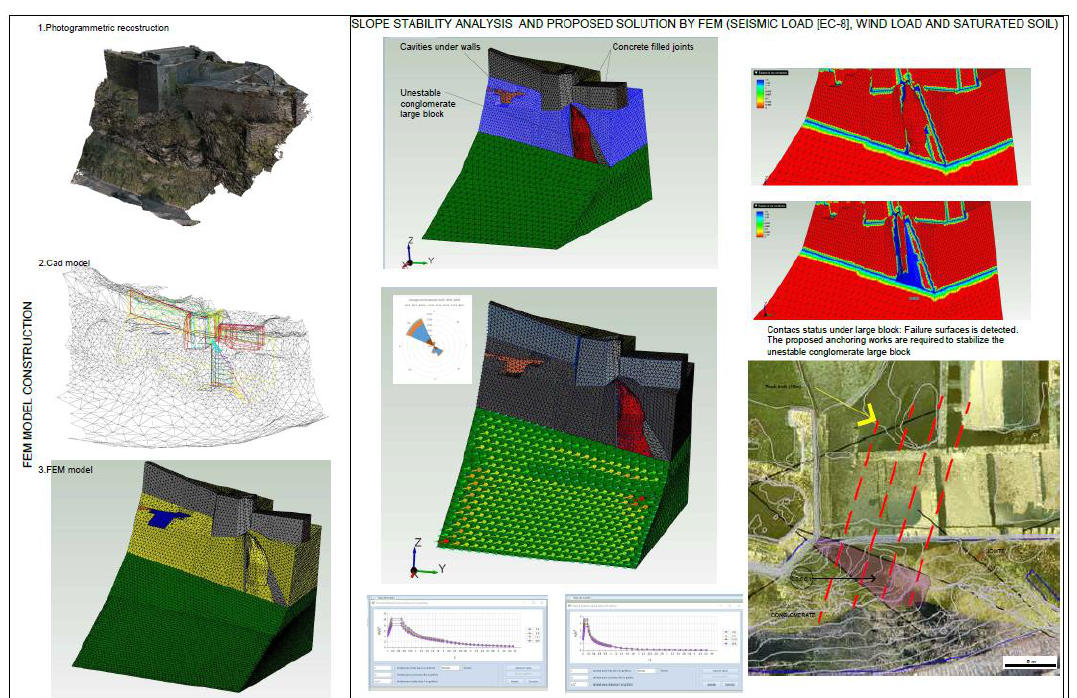
Figure 18. Example of FEM analysis carried out to evaluate and design an engineering solution to stabilize unstable rock blocks. (Photo credit: GEA, aerial photo by Rand Eppich)